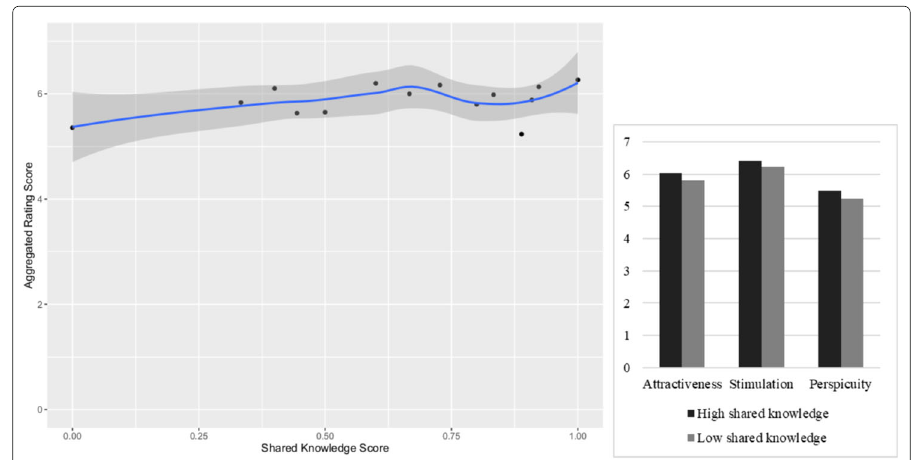
Fig. 10 Distribution of affective responses across different shared-knowledge scores